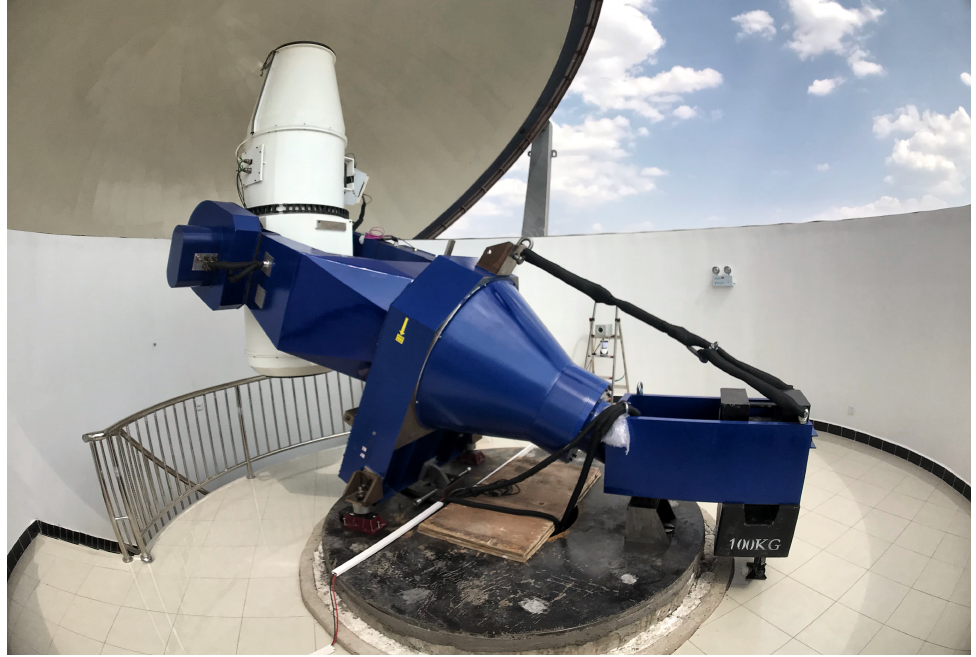
Figure 1. AST3-3 deployment in dome.